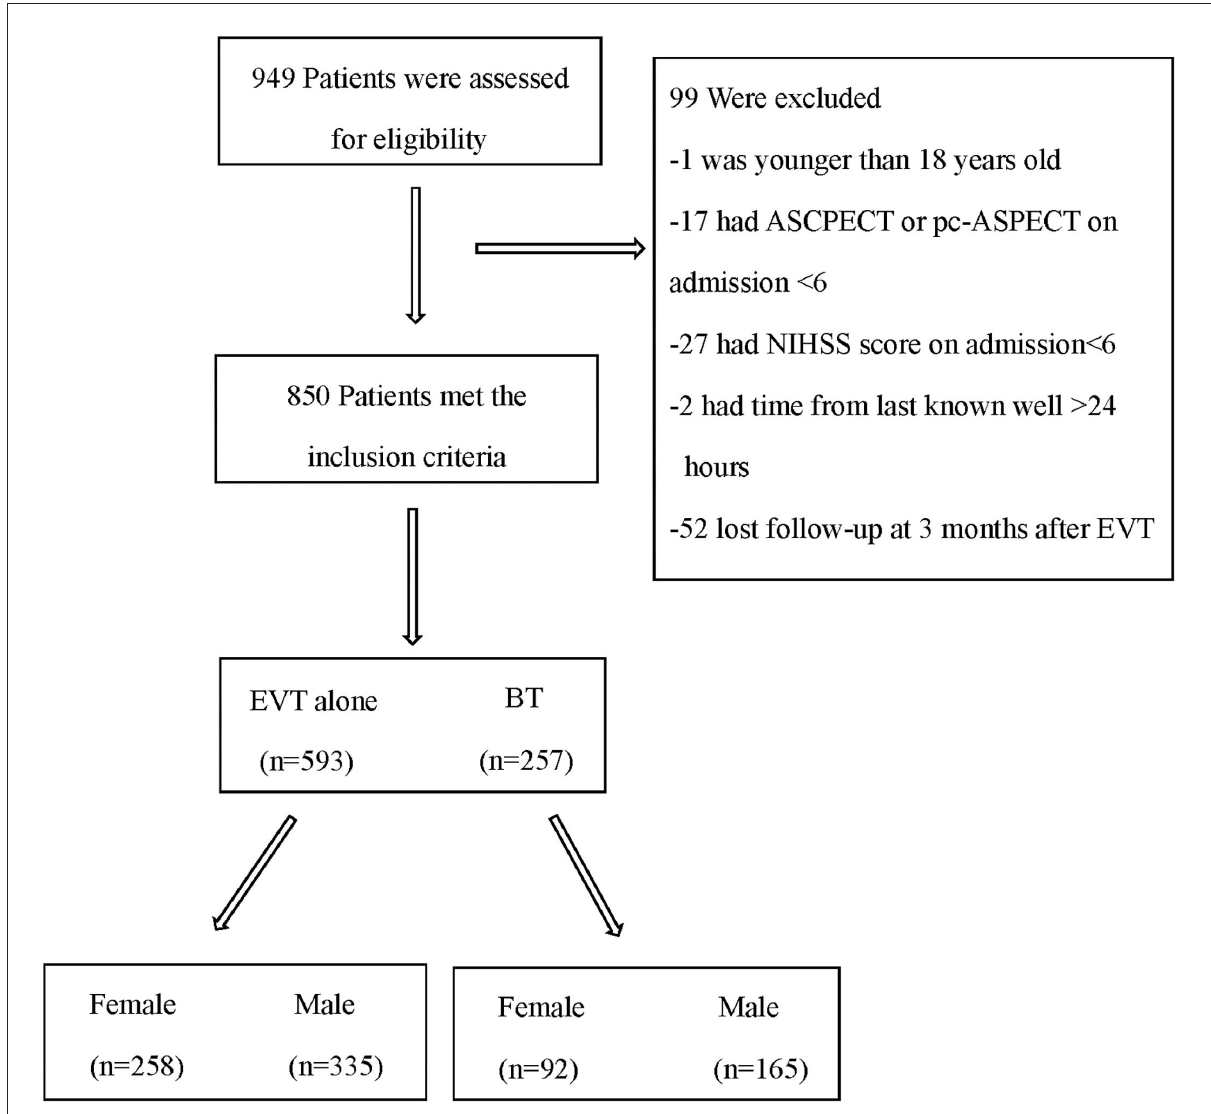
FIGURE1 Flowchart of patients in this study. EVT, endovascular therapy; BT, bridging therapy; ASPECT, Alberta stroke program early CT score (ASPECTS); pc-ASPECTS, posterior circulation Alberta stroke program early CT score; NIHSS, National Institutes of Health Stroke